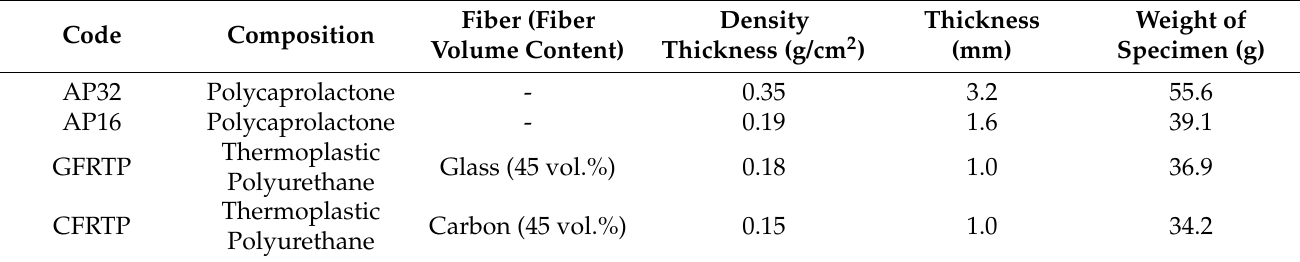
Table 1. Specifications of the materials